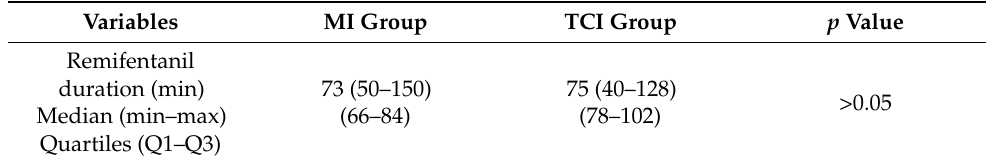
Table 2. Remifentanil duration.